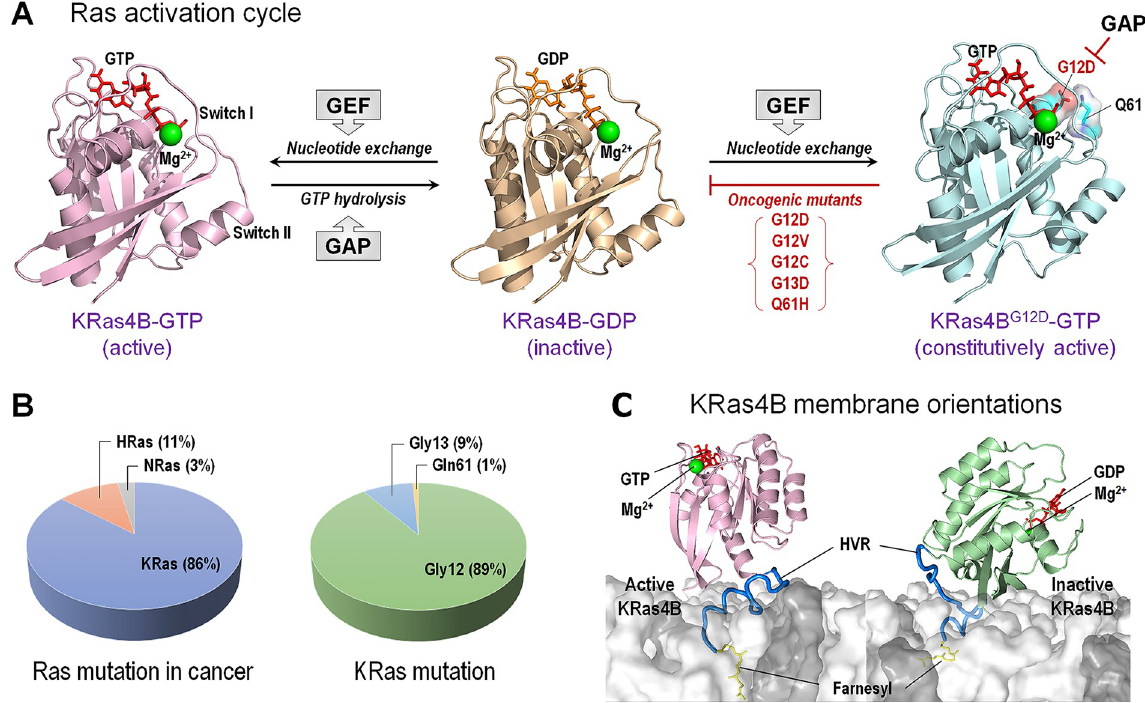
Fig 8. Ras activation and oncogenic mutations. (A) KRas4B is activated by the son of sevenless 1 (SOS1) nucleotide exchange factor (GEF), while GAP inactivates KRas4B via the GTP ! GDP hydrolysis. KRas4B oncogenic mutations at the active site Gly12, Gly13, and Gln61 aborts the hydrolysis reaction, keeping the Ras in a constitutively active GTP-bound state. (B) Of those with mutant Ras, KRas is the most highly mutated in cancer. In KRas mutation, Gly12 mutations are the most frequent. (C) The interactions of KRas4B with the anionic membrane composed of DOPC:DOPS (4:1 molar ratio). In the active GTP-bound state, the HVR is in contact with the membrane, but the catalytic domain is away, exposing the effector binding site. In contrast, autoinhibition persists in the inactive GDP-bound state with occluded catalytic domain conformation, yielding the effector binding site is inaccessible. In cartoons, the modeled KRas4B structures were adopted from our simulations [182, 285]. DOPC, 1,2-dioleoyl-sn-glycero-3-phosphocholine; DOPS, 1,2-dioleoyl-sn-glycero-3-phospho-L-serine; GAP, GTPase-activating protein; GEF, Guanine nucleotide exchange factors; HVR, hyper variable region; SOS1, son of sevenless 1.